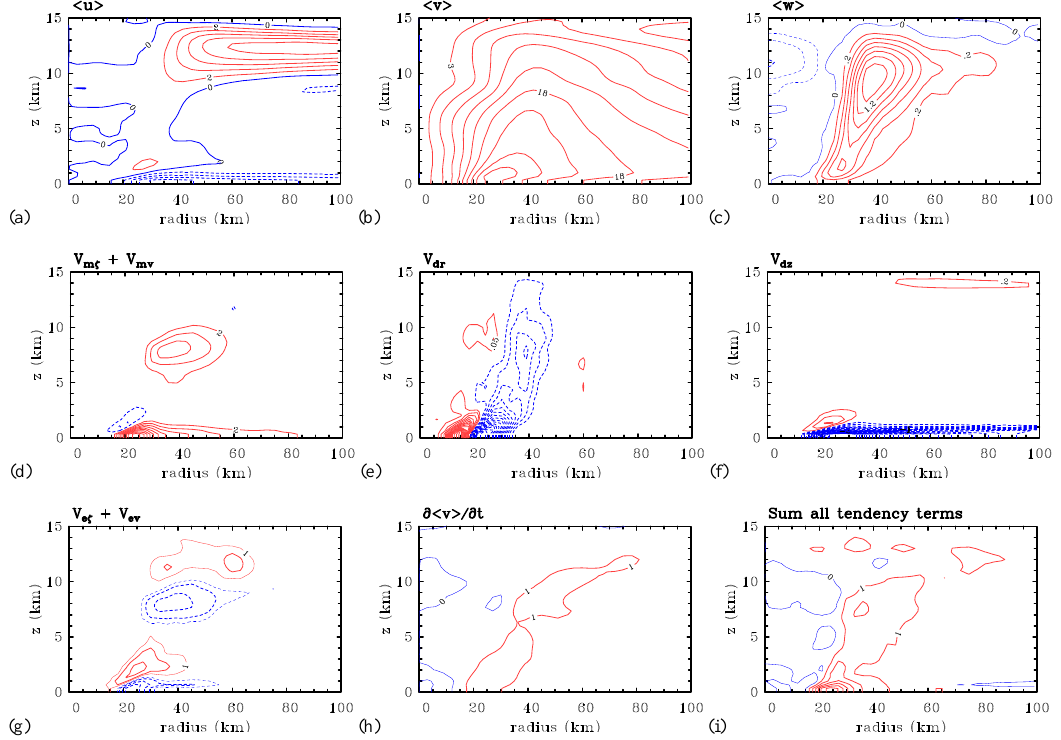
Fig. 10. Terms of the tangential wind tendency equation for the simulation 3D3k, averaged during the period of rapid intensification (65–69 h). Red contours denote positive values; blue contours denote negative values. (a) Radial velocity h u i (Contour interval 2ms − 1 ); (b) tangential velocity h v i (Contour interval 3ms − 1 ); (c) vertical velocity h w i (Contour interval 0.2ms − 1 ; blue contours − 0.1, − 0.05, and 0ms − 1 ); (d) sum of mean vorticity influx and vertical advection V m ζ + V mv (Contour interval 2ms − 1 h − 1 ); (e) radial (subgrid-scale) diffusive tendency V d r (Contour interval 0.05ms − 1 h − 1 ); (f) vertical (subgrid-scale) diffusive tendency V d z (Contour interval 0.2ms − 1 h − 1 ); (g) combined eddy tendencies V e ζ + V ev (Thick contour interval is 2ms − 1 h − 1 , thin contours are ± 1ms − 1 ); (h) mean tangential wind tendency ∂ h v i /∂t (Contour interval 1.0ms − 1 h − 1 ); (i) sum of all tendency terms (Contour interval 1.0ms − 1 h − 1